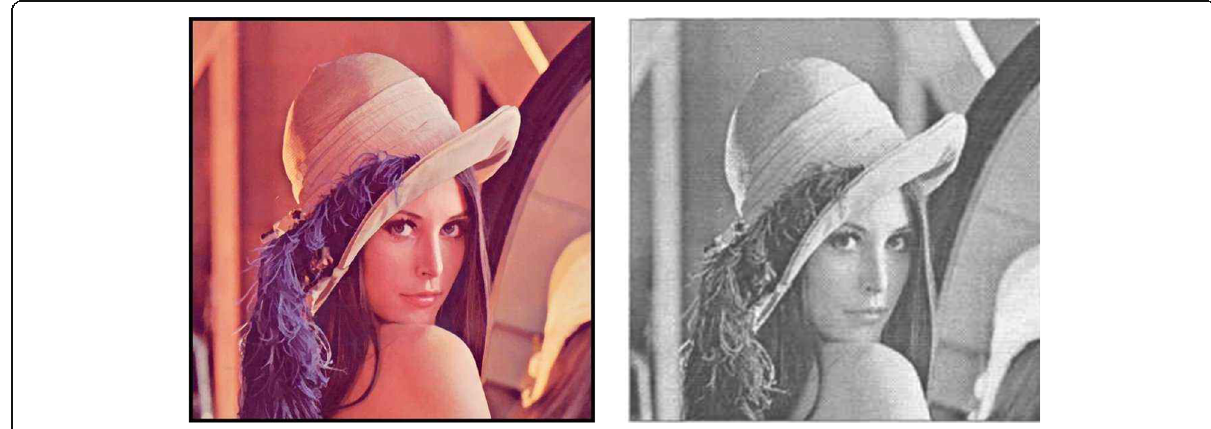
Fig. 2 Grayscale processing of the original picture